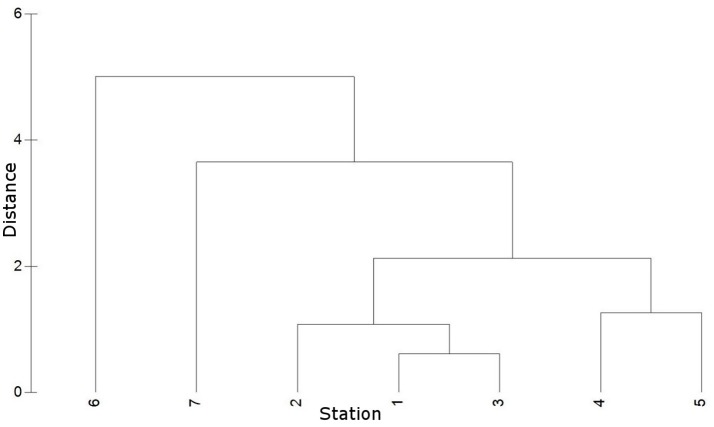
Hierarchical cluster (group average) based on Euclidian distances of environmental data (temperature, salinity, PO43-, NO3-, NO2-, NH4+). Cluster displays similarity of environmental conditions at stations 1 to 7.